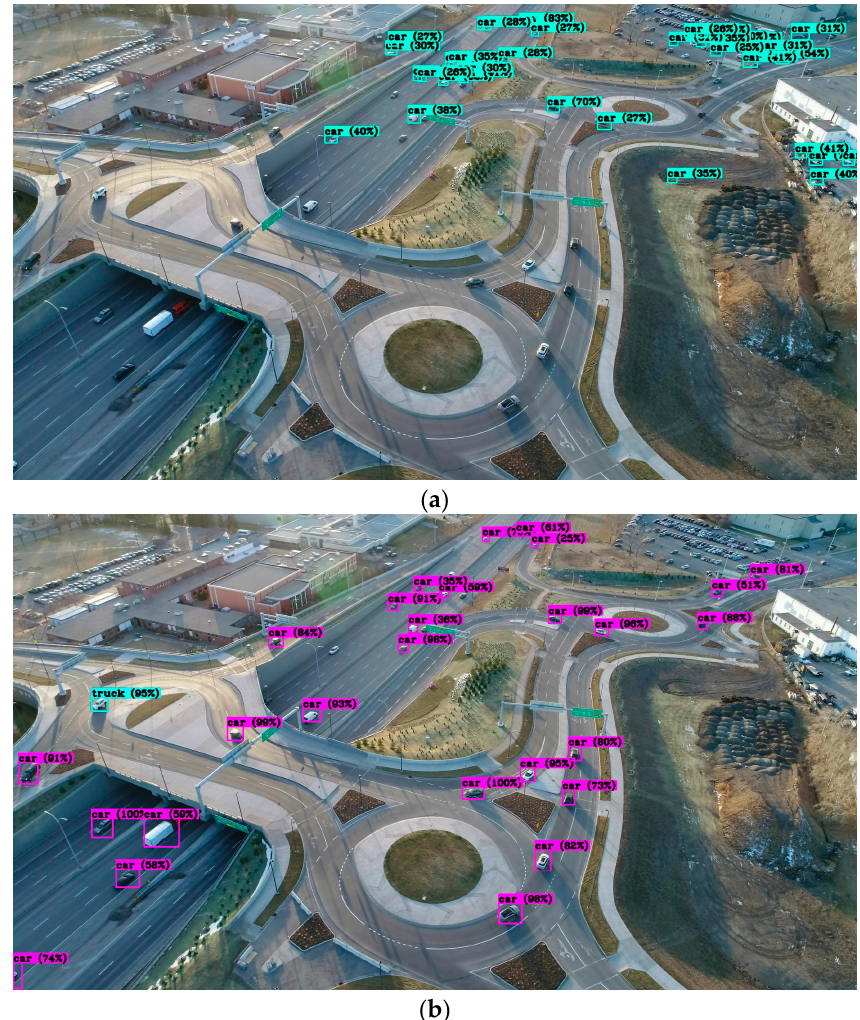
Figure 3. Vehicle detection in UAV videos: ( a ) vehicle detection by YOLOv3 trained via ground-surveillance videos; ( b ) vehicle detection by fine-tuning YOLOv3 using custom-labeled airborne videos.